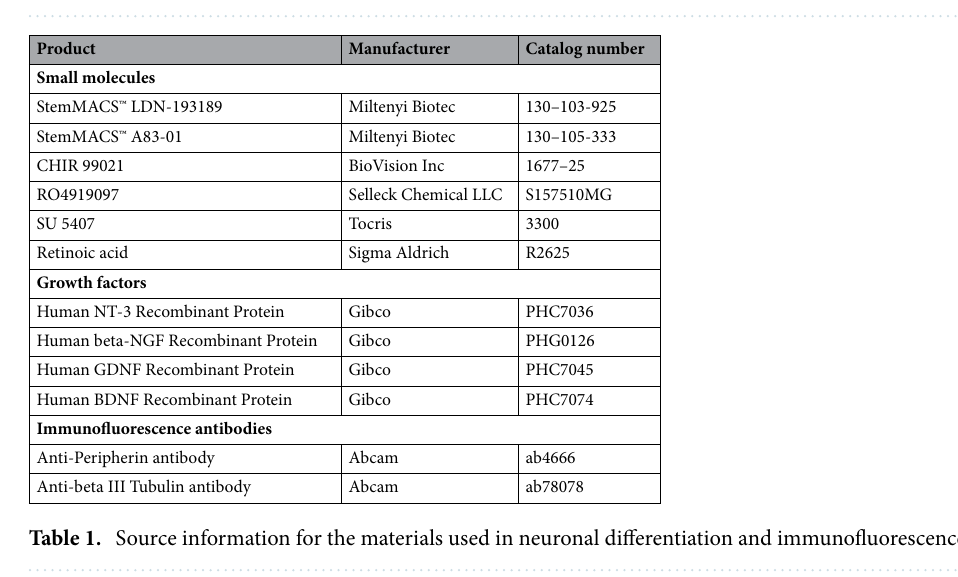
Figure 5. Timeline of reprogramming iPSCs from peripheral blood and subsequent neuronal differentiation.